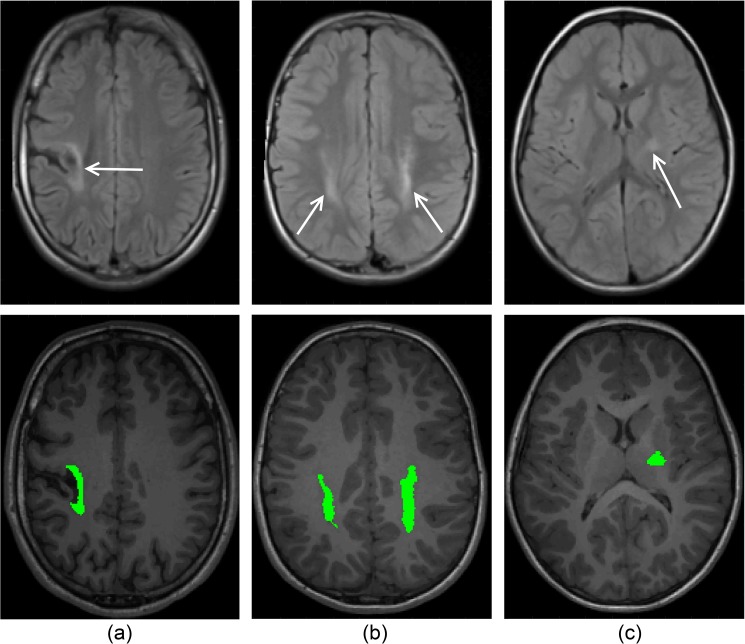
Illustration of lesion segmentation.(A) GM lesion segmentation, (B), WM lesion segmentation and (C) internal capsule lesion segmentation.